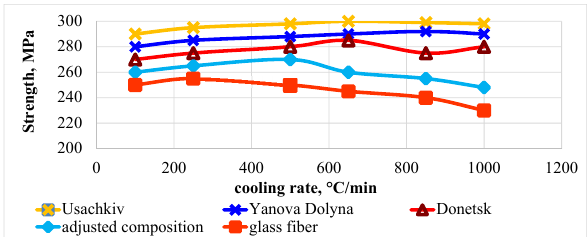
Fig. 5. The effect of the melt broaching speed on the strength of basalt fiber